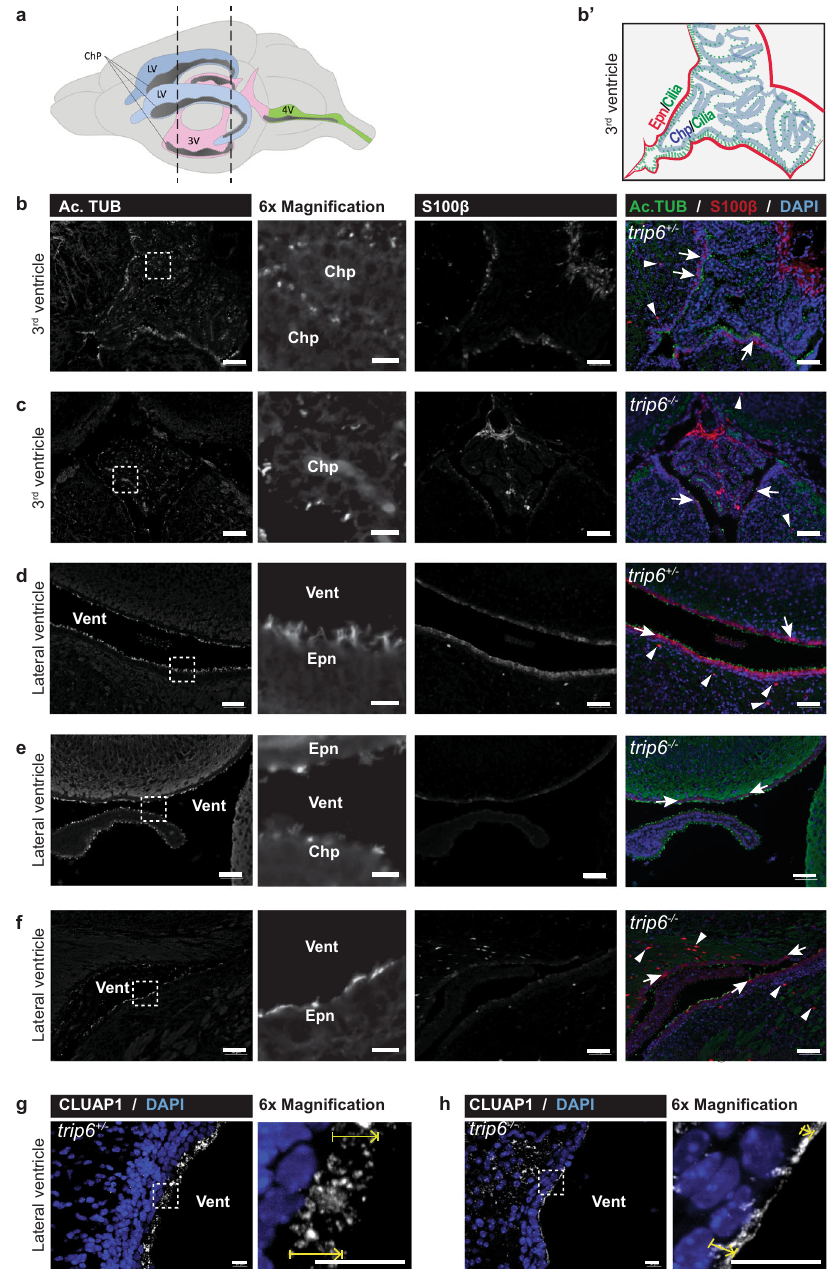
Fig. 4 Defective differentiation of ependyma and choroid plexus in trip6 − / − mice. Schematic illustration of mouse brain ventricles and choroid plexus, with vertical lines indicating the approximate coronal section planes analyzed ( a ). Scheme ( b ′ ) and immuno fl uorescence microscopy analysis ( b ) of ependyma (Epn) and choroid plexus (Chp) within the 3rd ventricle (Vent: ventricular lumen) in control brain sections, illustrating ciliation and ependymal cell differentiation [visualized by acetylated tubulin (Ac.TUB) and S100 β labeling, correspondingly]. Nuclear DNA is stained by DAPI. Note that S100 β is expressed in ependymal (arrows, b – f ) but also in non-ependymal cells (arrowheads, b – f ). Trip6 deletion ( c ) results in differentiation defects indicated by reduction in ciliation and S100 β expression. Importantly, these defects [which are apparent also in the LV (Vent) ( e , f cf . control d )] are observed in mice with ( e ) or without ( f ) hydrocephalus, suggesting that differentiation defects precede development of this pathology. For higher magni fi cation images, please see Supplementary Fig. 3. Defective ciliation in trip6 − / − brain is further demonstrated by labeling the ciliary transport protein CLUAP1 ( h ). Yellow arrows indicate the height of the cilia lawn in control ( g ) and trip6 − / − ( h ) specimens. Scale bars: 50 μ m ( b – f ), 10 μ m ( g , h